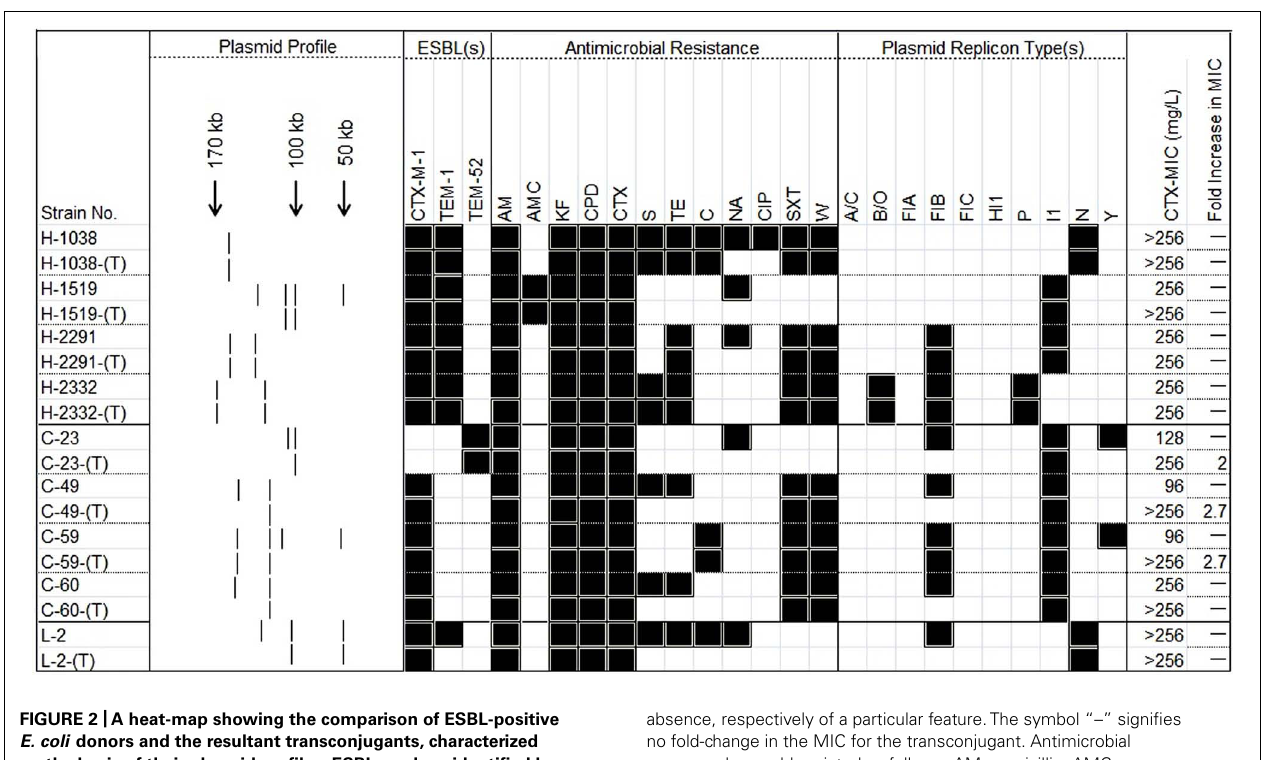
absence, respectively of a particular feature.The symbol “–” signifies no fold-change in the MIC for the transconjugant. Antimicrobial compounds are abbreviated as follows: AM, ampicillin; AMC, amoxicillin–clavulanic acid; C, chloramphenicol; CPD, cefpodoxime; CIP, ciprofloxacin; CTX, cefotaxime; KF, cephalothin; NA, nalidixic acid; S, streptomycin; SXT, trimethoprim-sulfamethoxazole;TE, tetracycline; W, trimethoprim.